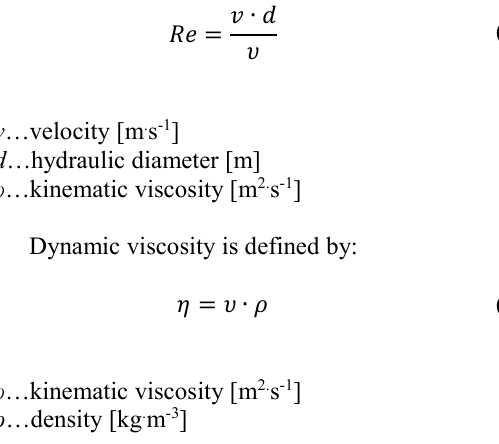
Table 1. Characteristics of defined mathematical model